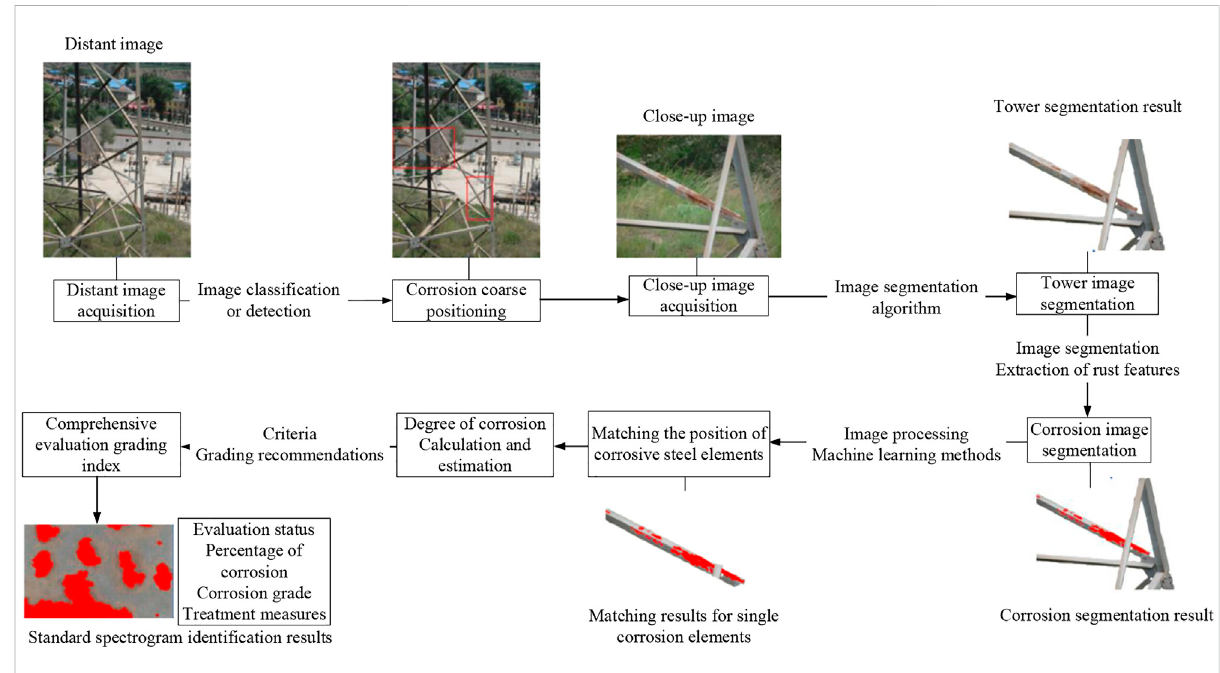
FIGURE 3 Corrosion recognition algorithm process for transmission and transformation steel components.